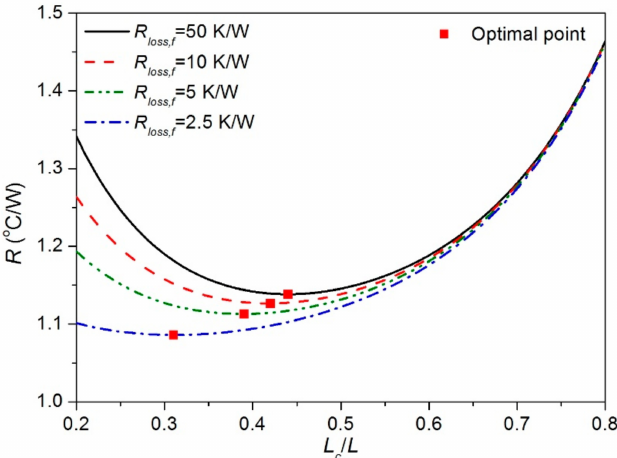
Figure 8. Thermal resistances for various heat losses through the front of the heat sink ( Q = 0.2 m 3 / min, w c = 7 mm, L h / L = 0.2).